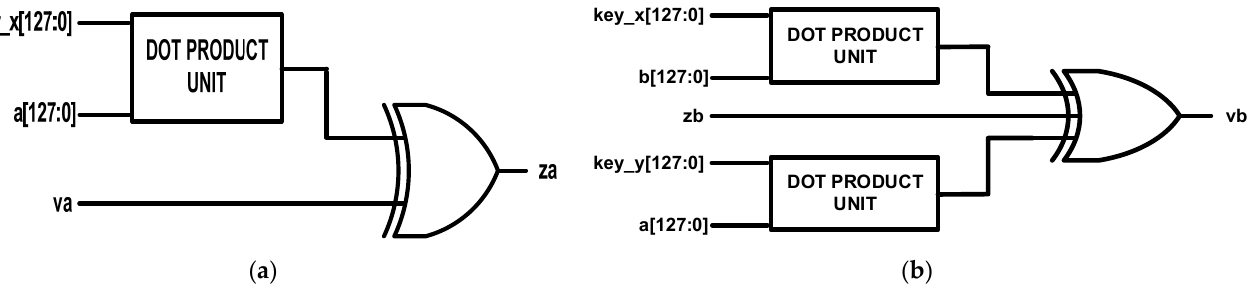
Figure 11. Proposed computation units: ( a ) COMPUT1 unit; ( b ) COMPUTE2 unit.